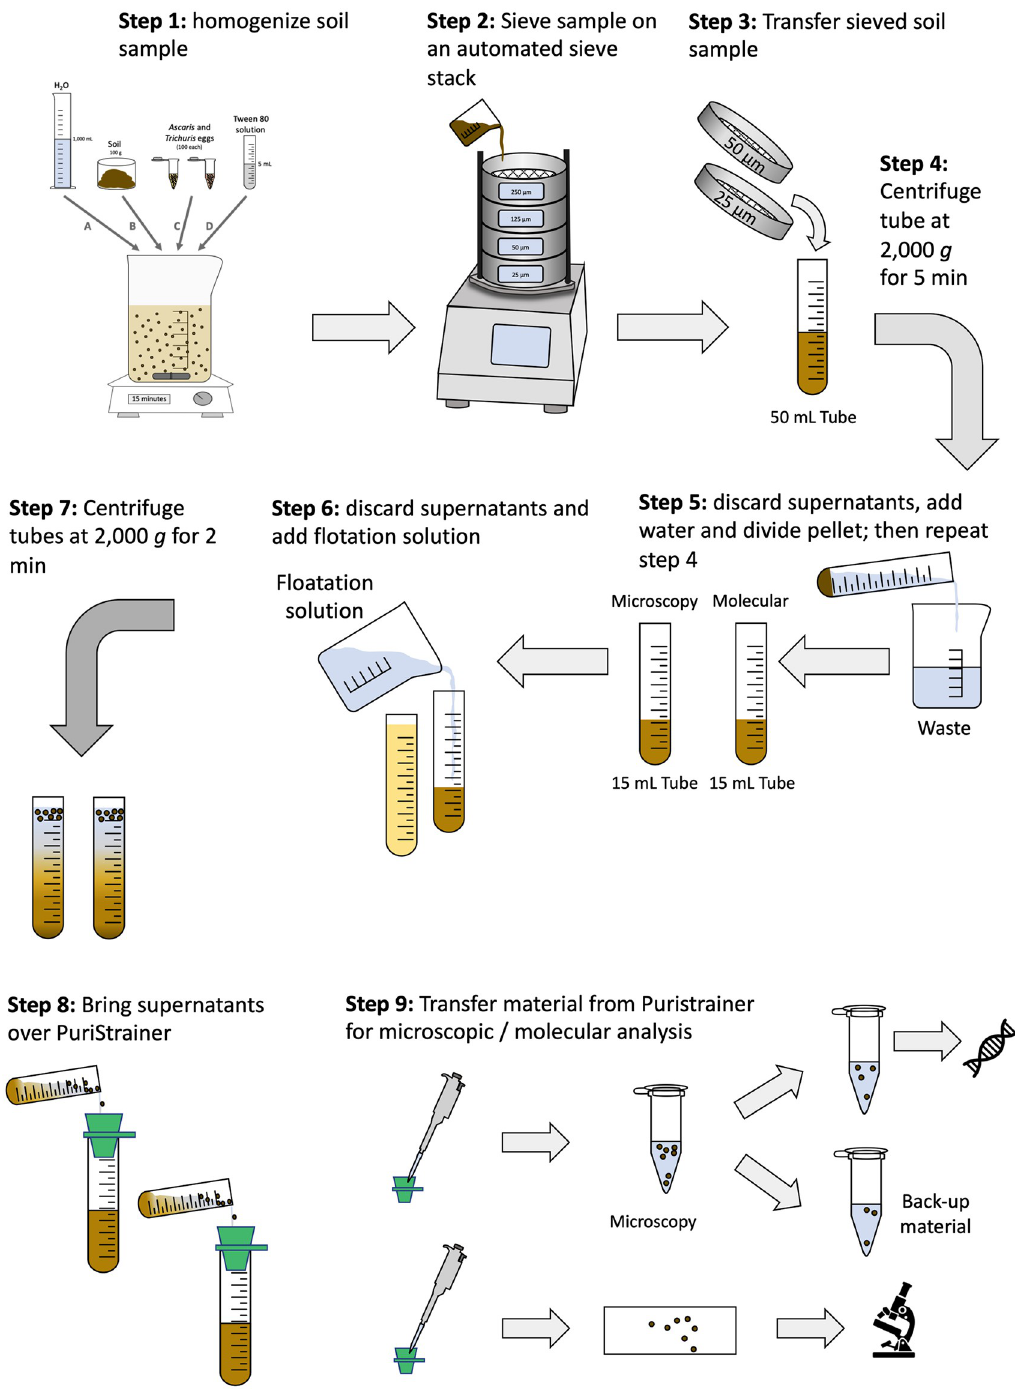
Fig 1. The different steps of the optimized straining-flotation method to detect and quantify STH eggs/larvae in soil. The optimized straining-flotation method consists of 9 consecutive steps, including the homogenization of the soil sample ( step 1 ), sieving of the sample ( step 2 ), the transfer of the sieved soil into a 50 mL tube ( step 3 ), centrifugation of this test tube at 2,000 g for 5 min ( step 4 ), discard supernatant, add water to bring the pellet to suspension, equally divide suspension over two 15 mL tubes, and repeat the centrifugation step ( step 5 ), discard supernatants and add flotation solution to each of the test tubes ( step 6 ), centrifuge the tubes at 2,000 g for 2 min ( step 7 ) and put the supernatants over a PuriStrainer sieve ( step 8 ), transfer the material from the PuriStrainer sieve to a microscopic slide or in a 2 mL tube for microscopic or molecular analysis, respectively ( step 9 ).